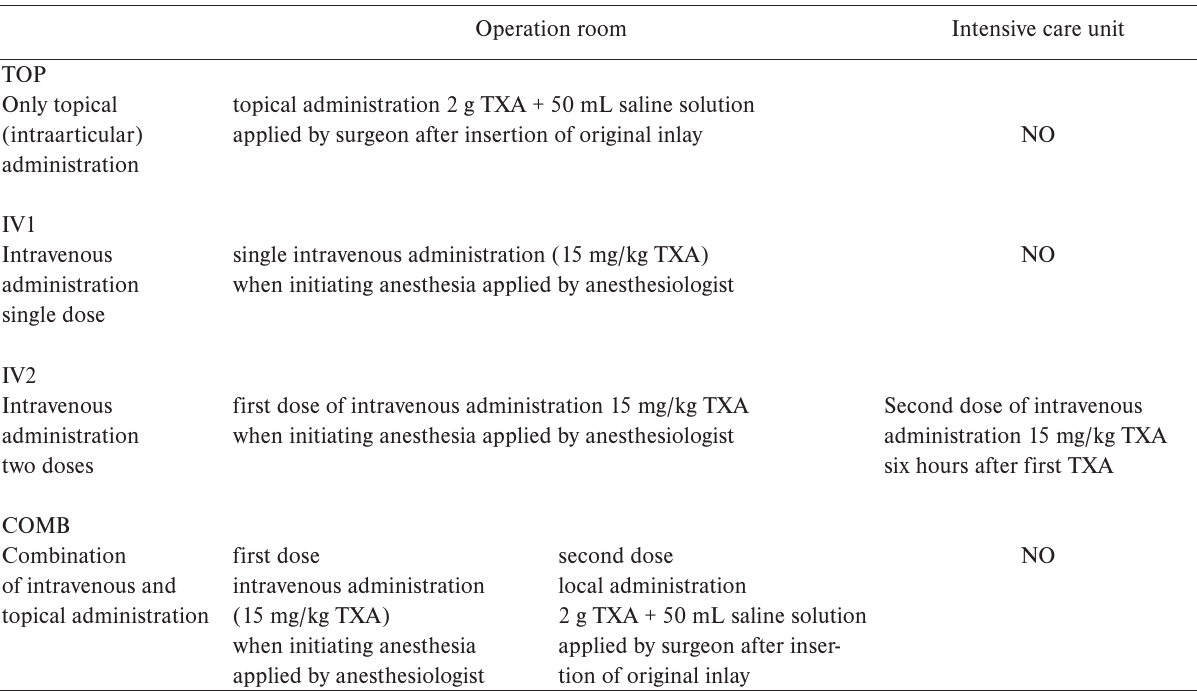
Table 2. TXA administration protocols. Operation